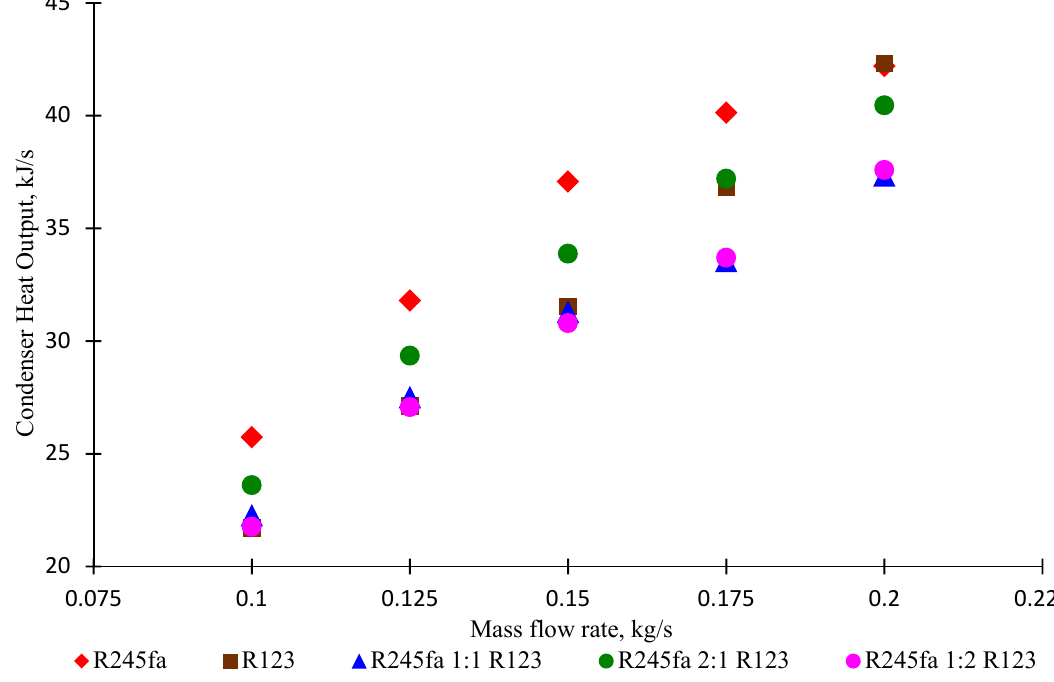
Figure 20. Condenser heat output as a function mass flow rate for R245fa, R123, and mixed working fluids with heat source at 120 ° C.